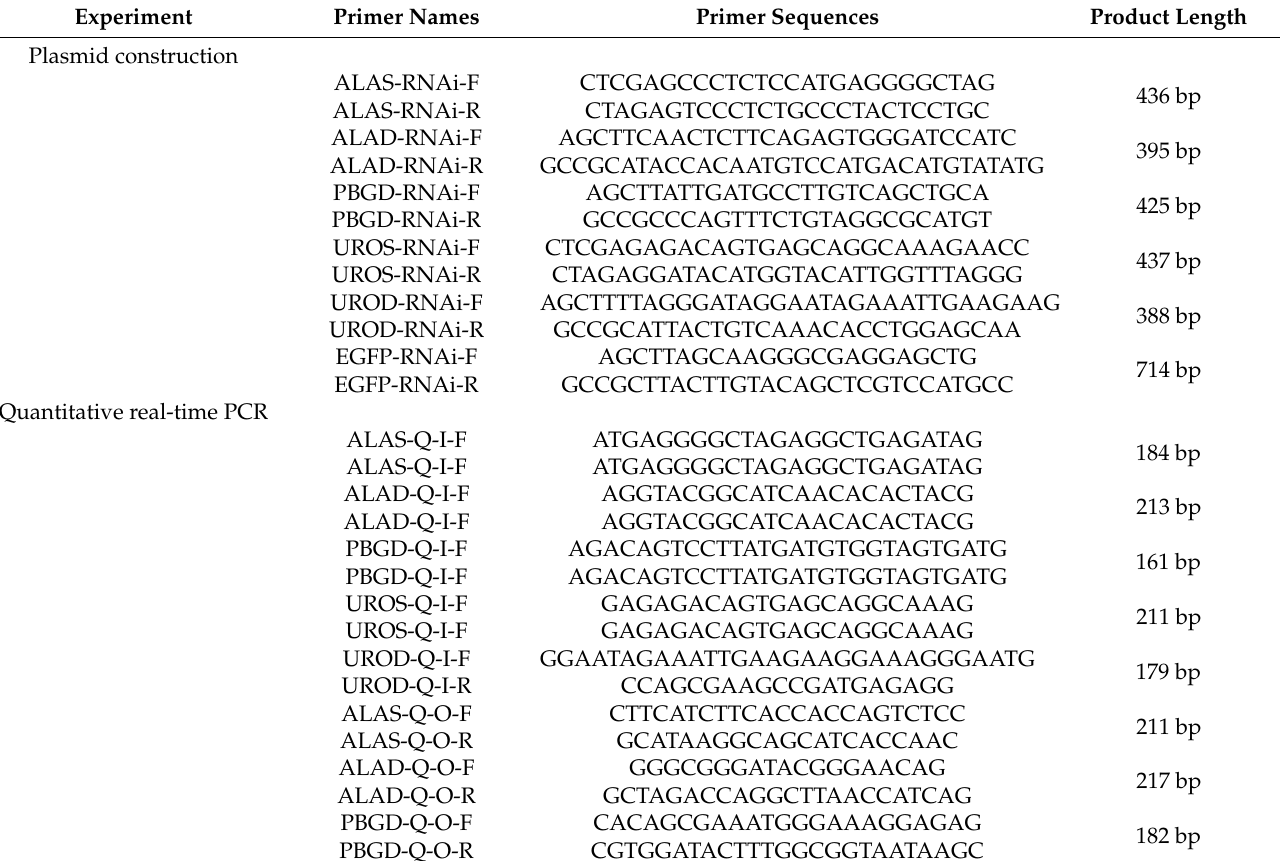
Table 2. Nucleotide sequences of specific primer pairs used in the present